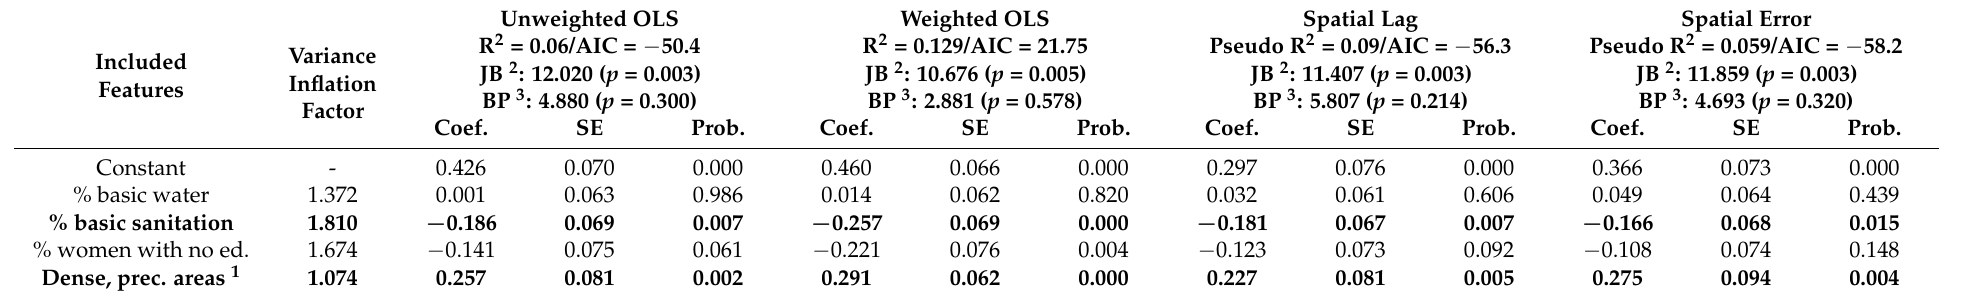
Table 3. Regression results of four models for the full dataset ( n = 267 spatial units), by model type.